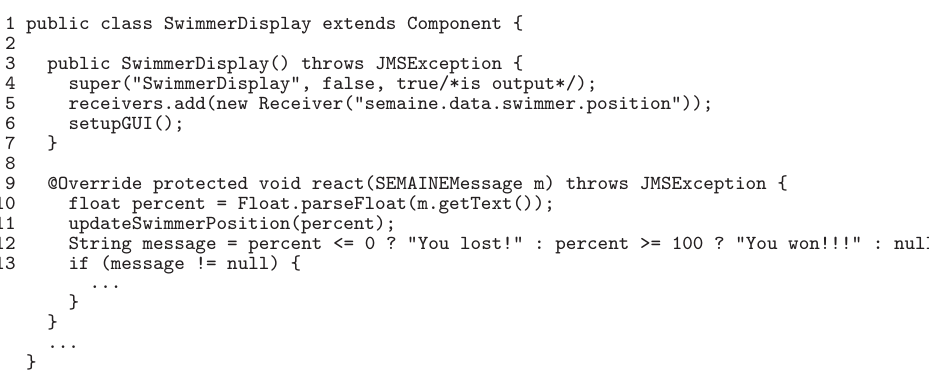
Figure 21: The SwimmerDisplay component (GUI code not